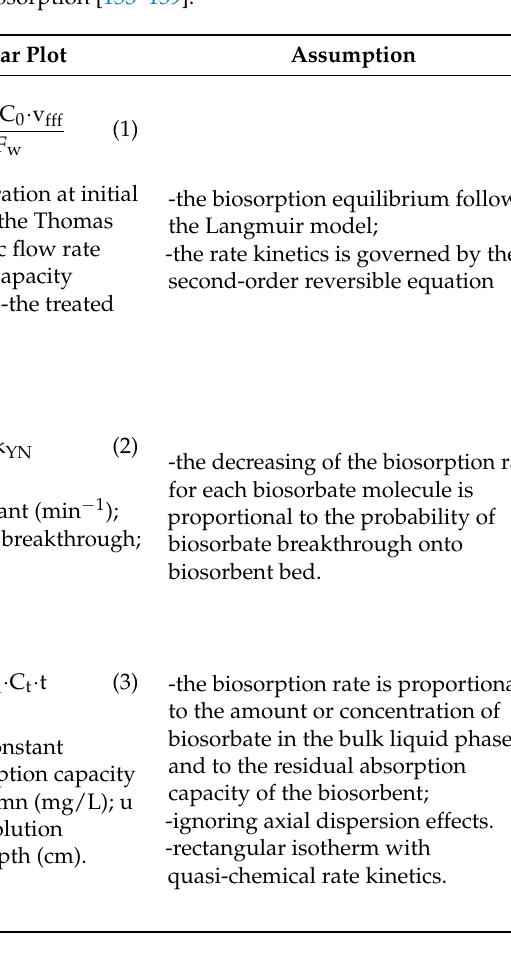
Table 2. Models of continuous fixed bed biosorption